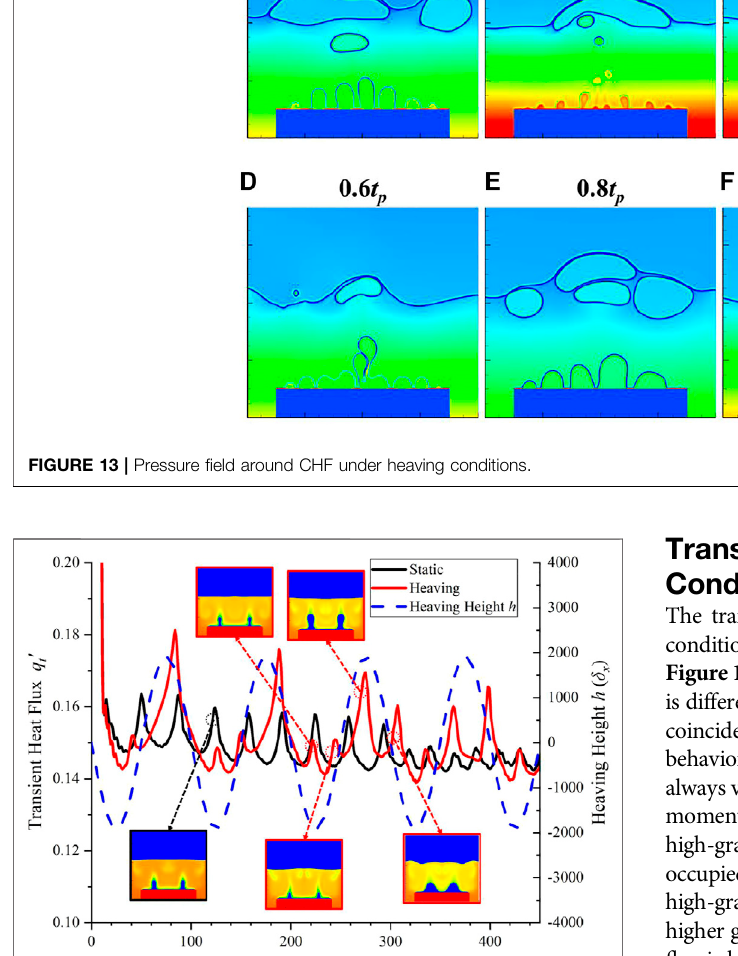
Frontiers in Energy Research |